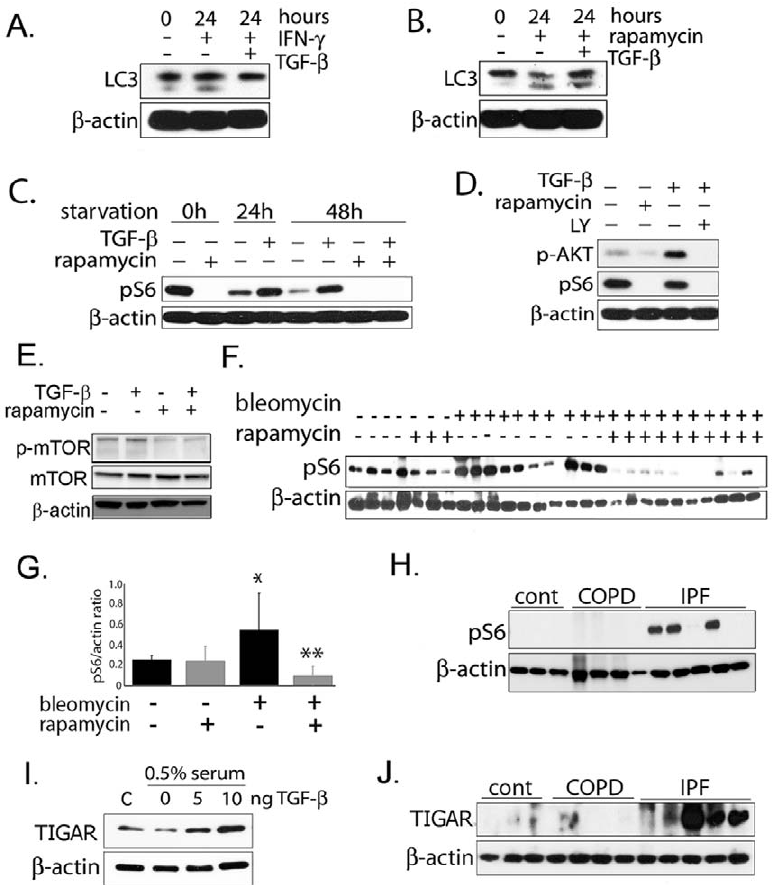
Figure 4. TGF- b 1 activates mTOR and TIGAR. A) In human lung fibroblasts, TGF- b 1 inhibits LC3-II formation, even in the presence of IFN- c which induces autophagy. B) TGF- b 1 is unable to inhibit LC3-II formation in presence of mTOR inhibitor rapamycin. C) TGF- b 1 is able to activate mTORC1 which results in increased phospho-S6 but this activation does not occur in the presence of rapamycin. D) TGF- b 1 appears to activate mTORC1 by activating upstream PI3K/AKT and treatment with PI3K inhibitor LY294002 prevents TGF- b 1 induced mTOR activation. E) Western blot of phospho- mTOR (Ser2448) showing increased phospho-mTOR with TGF- b 1 in fibroblasts and inhibition by rapamycin. F) Western blot of phospho-S6 from mouse lung tissue treated with bleomycin and rapamycin. G) Densitometry of blot from 4E. (*p=0.03 for controls vs. bleomycin, **p=0.003 for bleomycin vs rapamycin + bleomycin). H) phospho-S6 protein levels in human lung tissue is higher in IPF patients compared with COPD patients and healthy controls. I) TIGAR is induced by TGF- b 1 in fibroblasts in a dose-responsive manner. J) Western blot demonstrating TIGAR protein levels in lung homogenate from human tissue is higher in IPF patients compared with COPD patients and healthy controls.